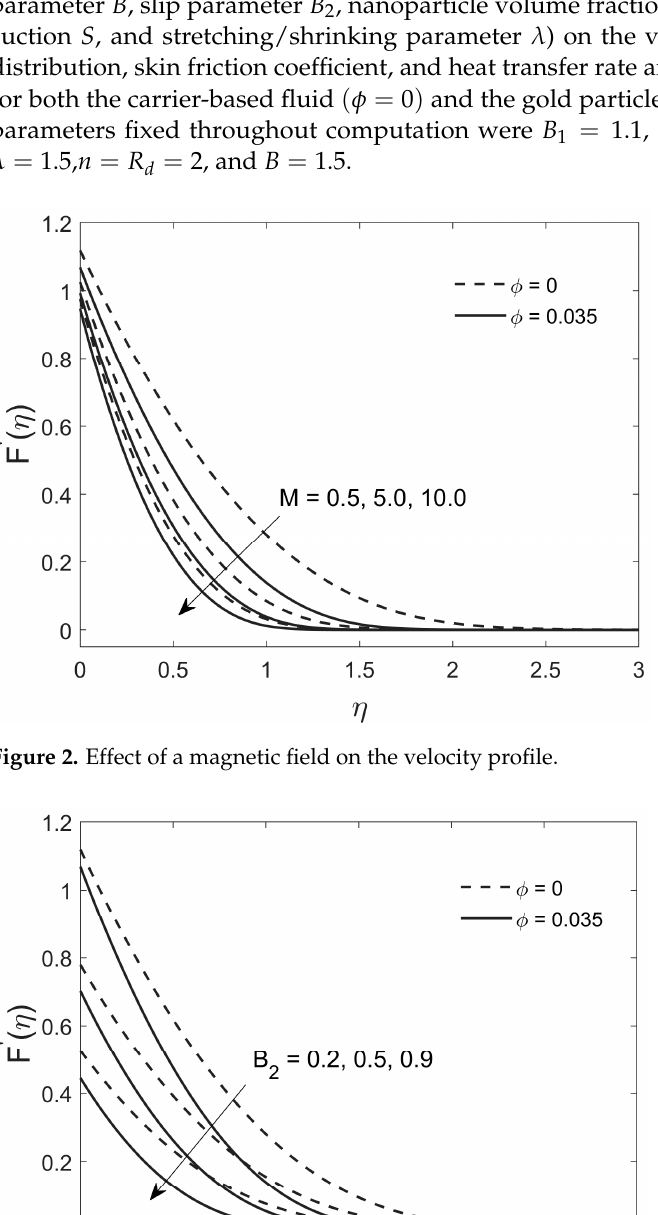
Figure 4. Effect of suction on the velocity profile.